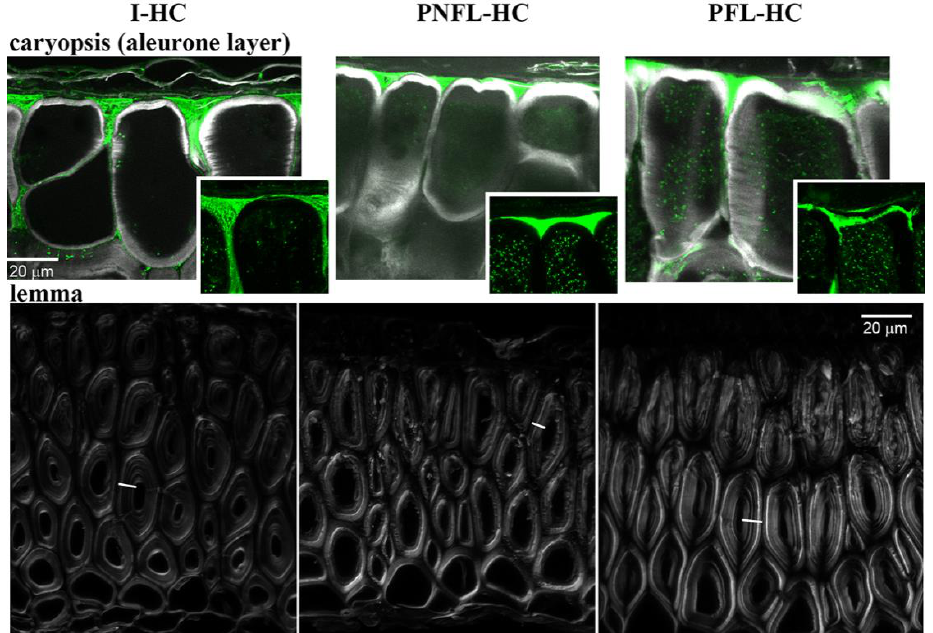
Figure 6. Confocal images of cross-sections of caryopsis aleurone layer (upper row) and lemma (lower row). Z-projections of maximal signal from confocal stacks were obtained using Fiji. For aleurone layer fragments, the overlaid LM11 (green) and Calcofluor White (grey) signals or only LM11 signal (insets) are shown. The dot-shaped LM11 signal from cell lumen likely results from nonspecific adherence of secondary antibody to cytoplasm organelles. In lemma cross-sections, thick-walled fibres were stained in Calcofluor White (grey) only. Line segments across the cell walls point to exemplary transects, shown in Figure 7, along which the grey signal intensity was measured. All images are shown at the same magnification.